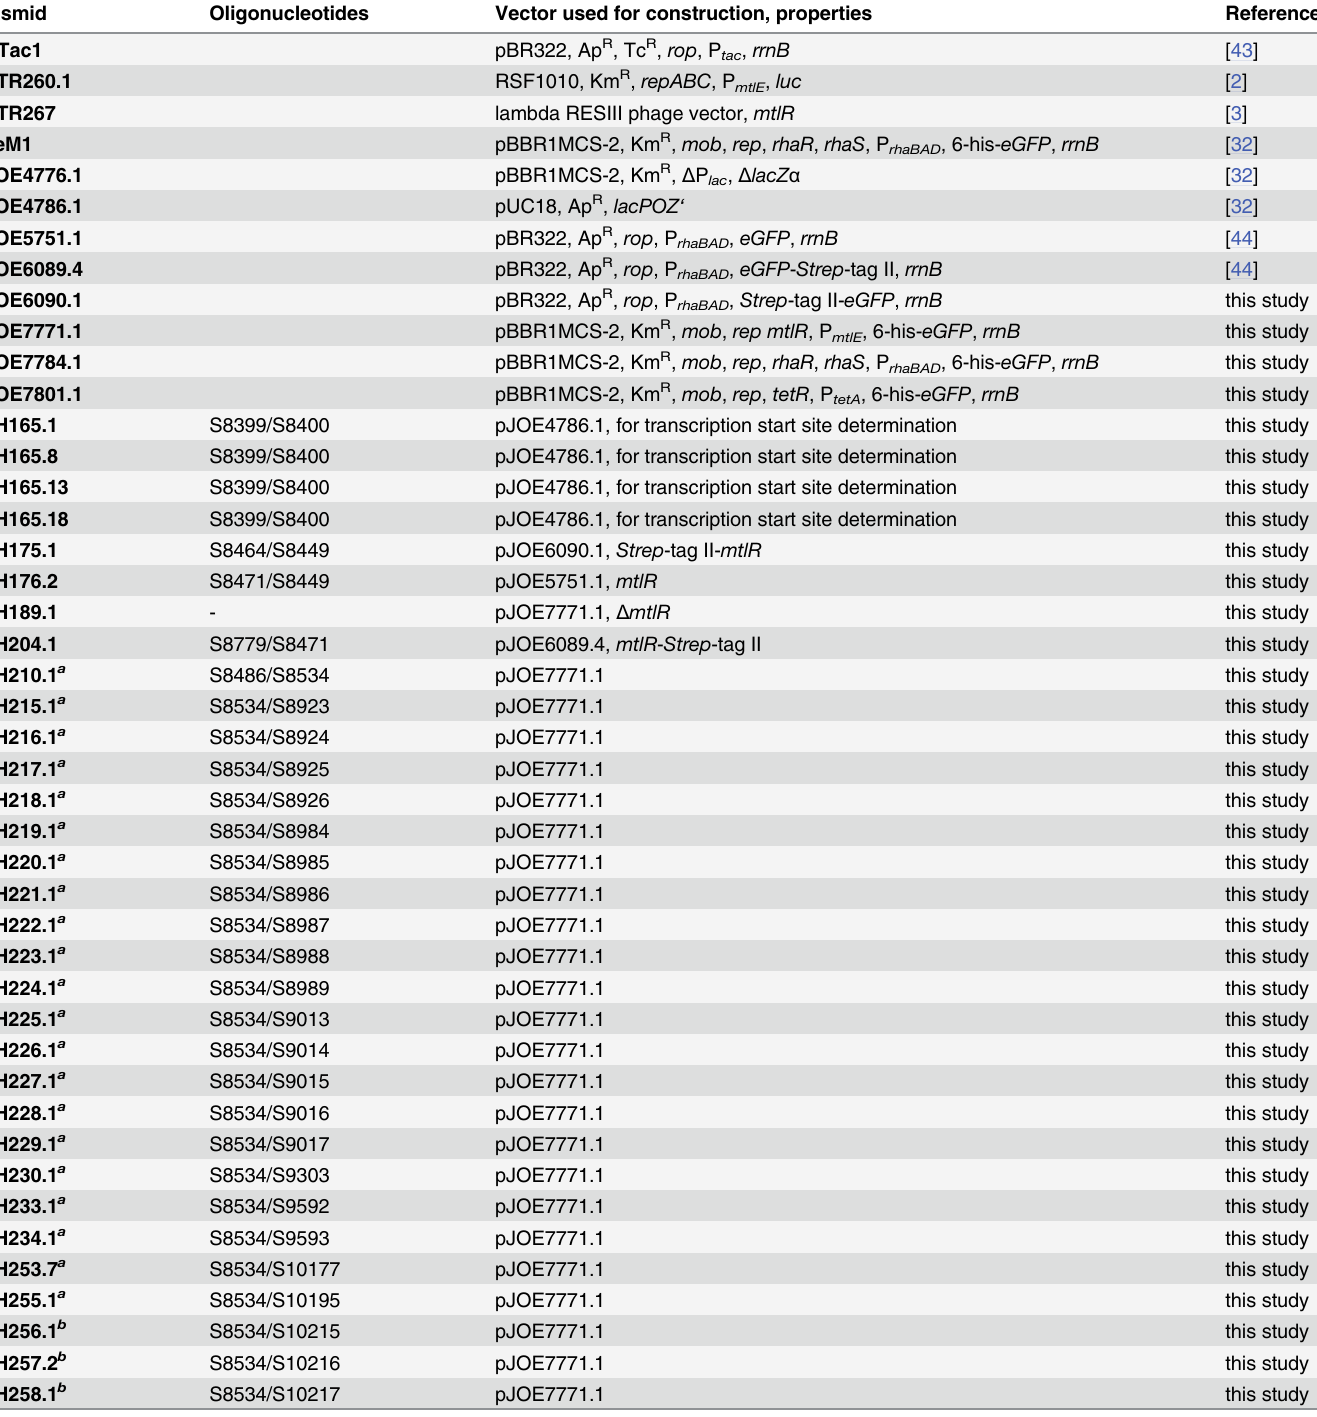
Table 1. Plasmids used in this study.